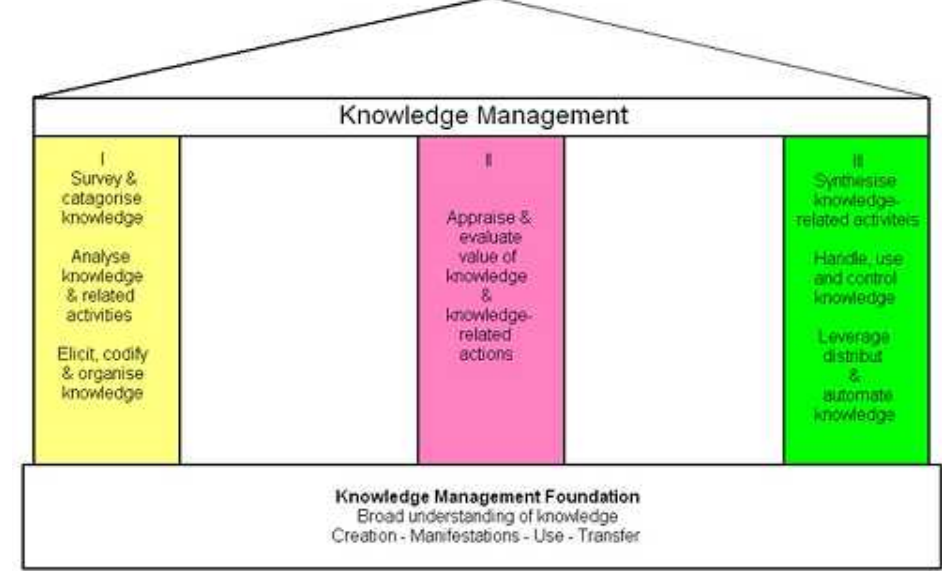
Figure 1 Three pillars of knowledge management (Source: Skyrme and Amidon